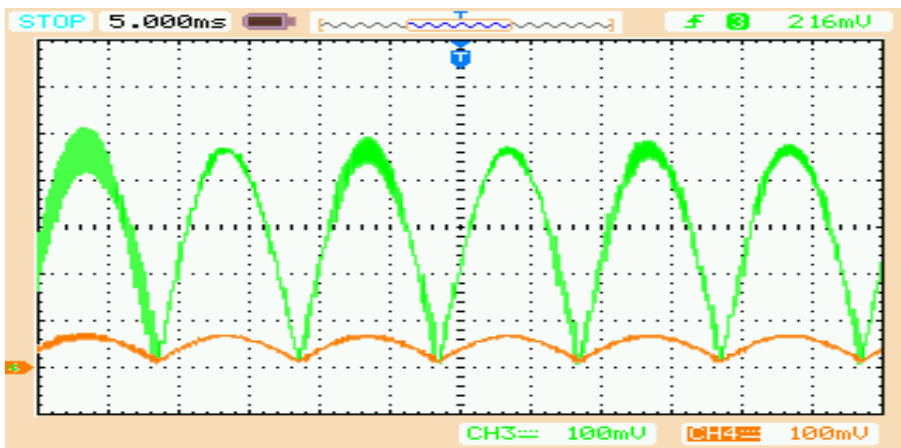
Figure 23. Output voltage profile of proposed scheme.